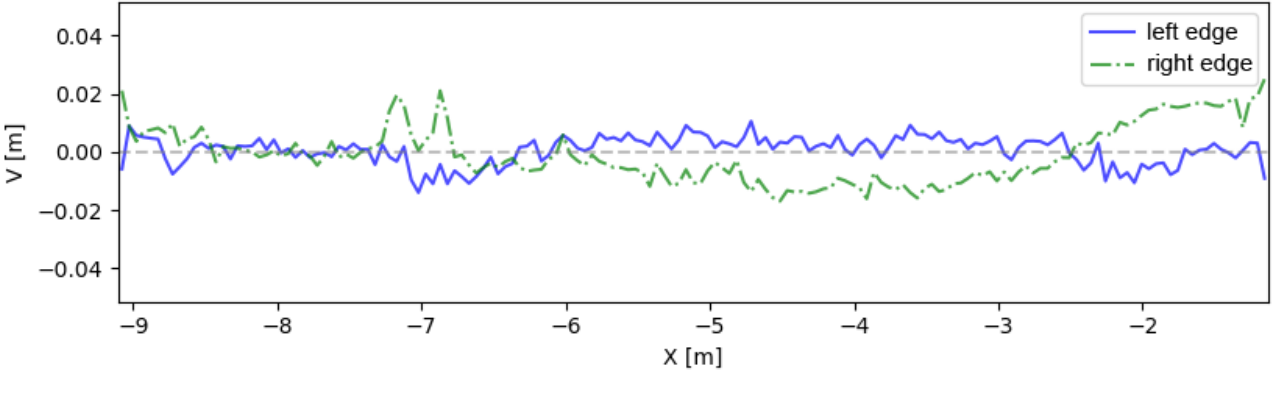
Figure 19. Line fit residuals of belt edges